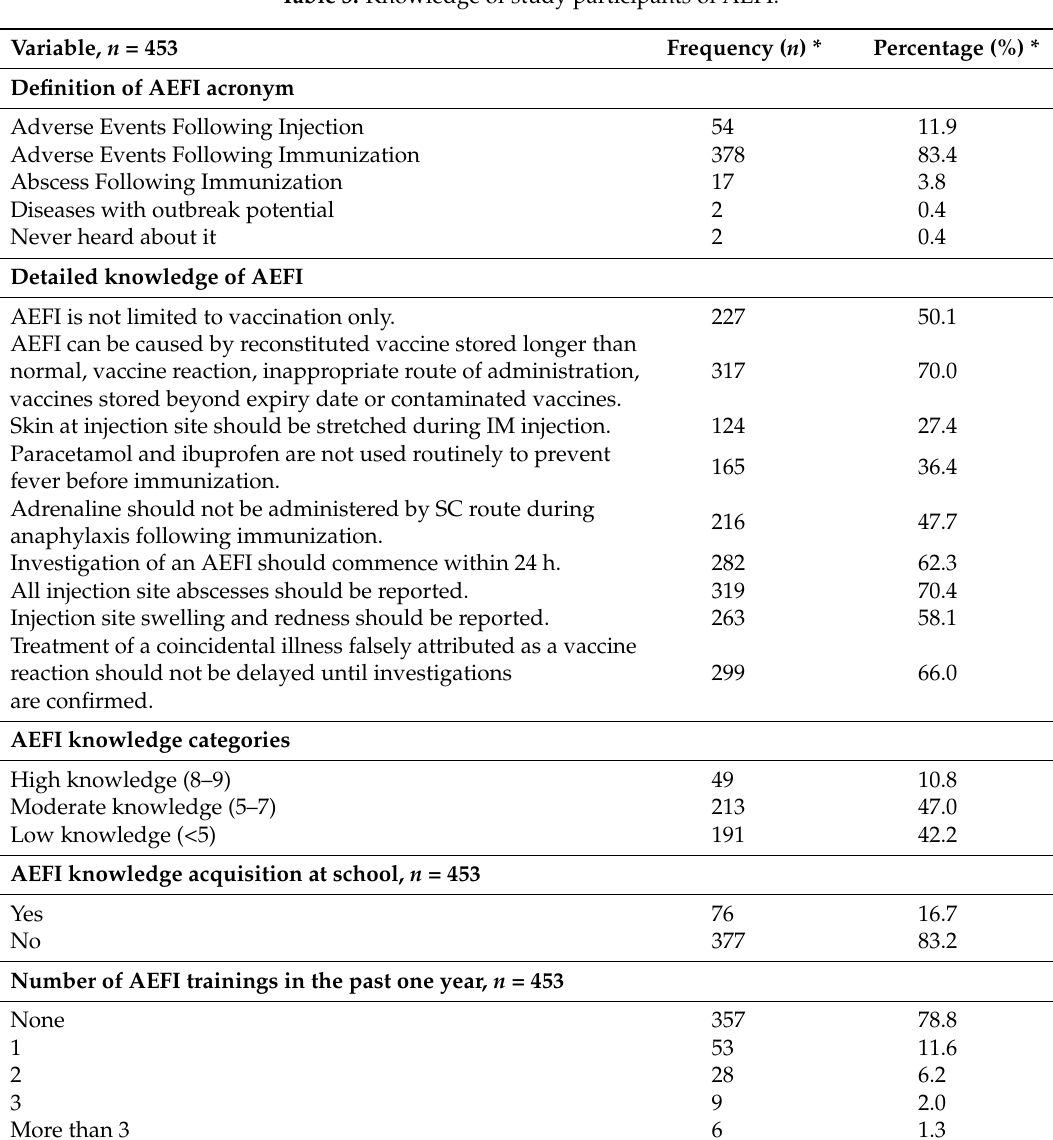
Table 3. Knowledge of study participants of